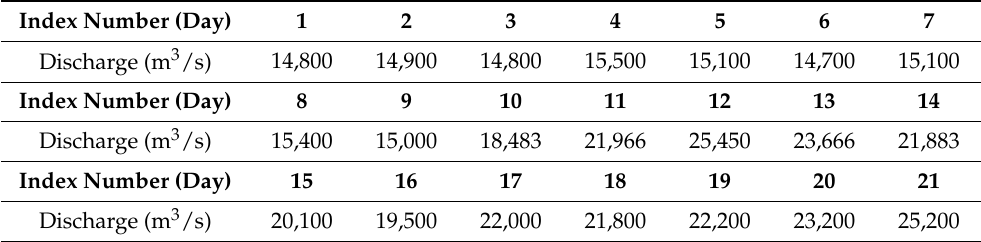
Table A2. Artificial flood pulse from 10 June to 30 June at the location of the